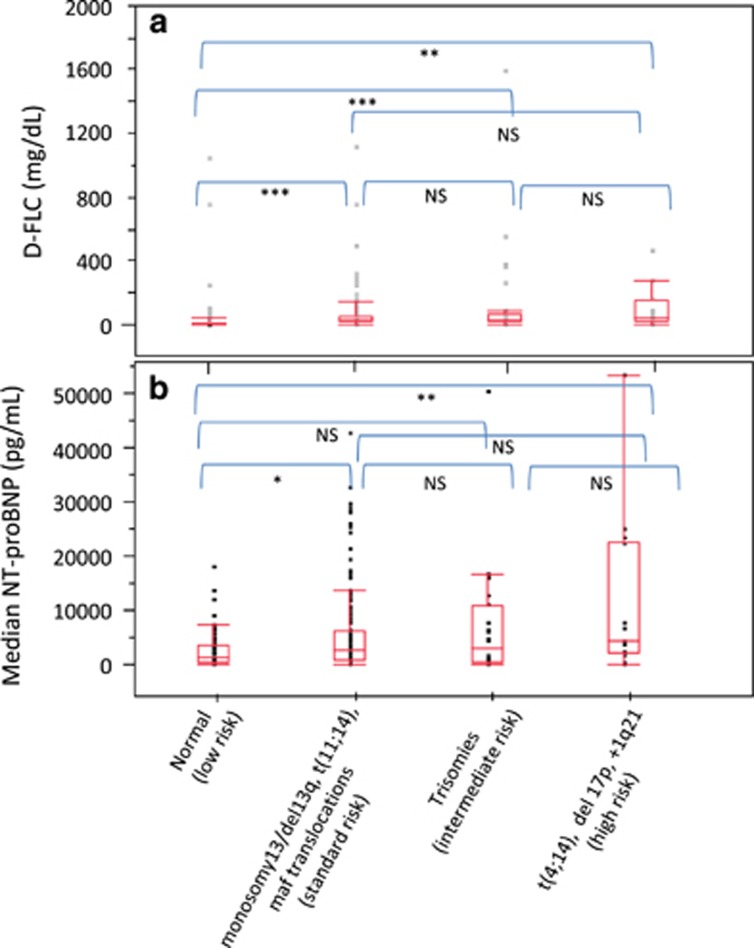
Association of smoldering myeloma risk stratifications with D-FLC and NT-proBNP. (a) The respective values (median (IQR)) for dFLC for low risk (n=71), standard risk (n=204), intermediate risk (n=75), high risk (n=15) were 7.76 (2.3–21.8), 25.65 (10.5–63.7), 24.35 (12–75.1) and 51.51 (10.5–159.2). (b) The respective values (median (interquertile region)) for NT-proBNP for low risk (n=49), standard risk (n=144), intermediate risk (n=44), high risk (n=13) were 1211 pg/ml (432–3509), 2777 pg/ml (575–6303), 2931 pg/ml (257–11132) and 4228 pg/ml (2081–22809). *<0.01, **<0.001 and ***<0.0001. NS=not significant.